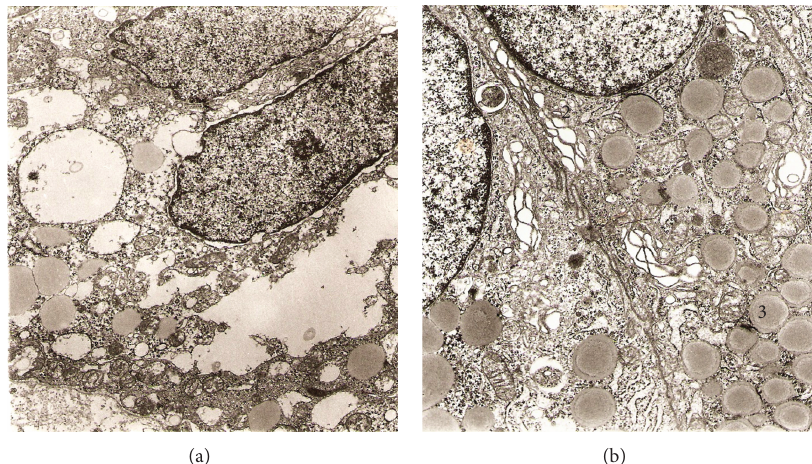
Figure 6: Electron micrographs from rat uterine horn (EtOH treated). (a) Epithelial cells show extended vacuolization, with nuclei having irregular shape and dilated perinuclear membrane (1), 8,800x. (b) Dilated Golgi complex (2) and numerous lipid drops in cytoplasm (3), 8,800x.